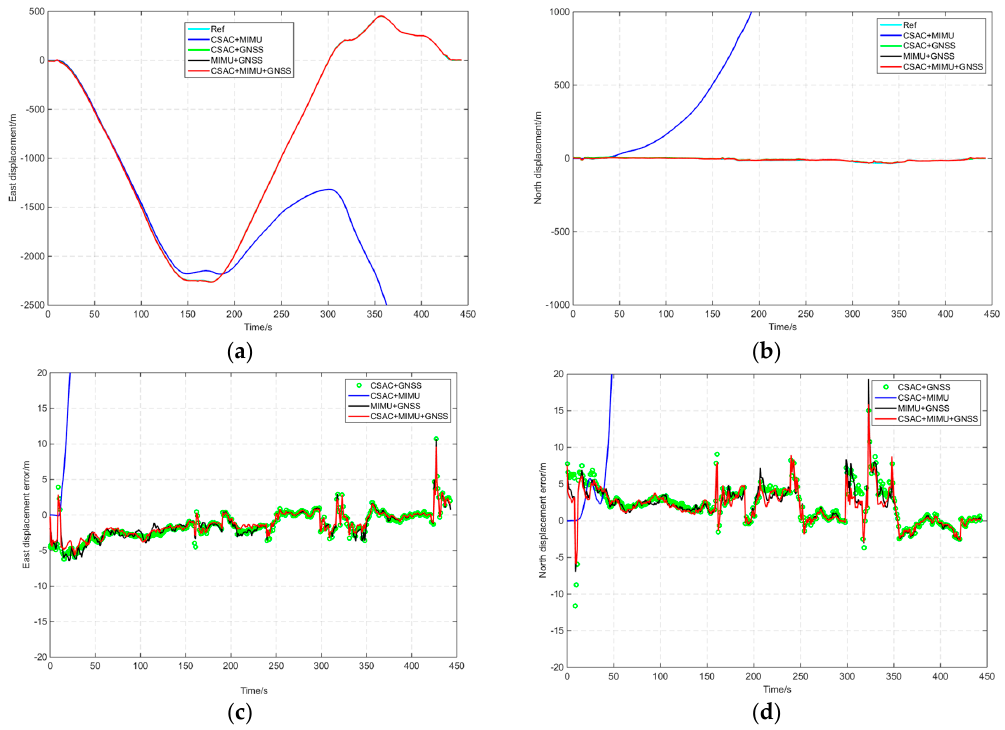
Figure 10. Navigation result comparison of the open-sky route. ( a ) East displacement with time; ( b ) North displacement with time; ( c ) East displacement error with time; ( d ) North displacement error with time.